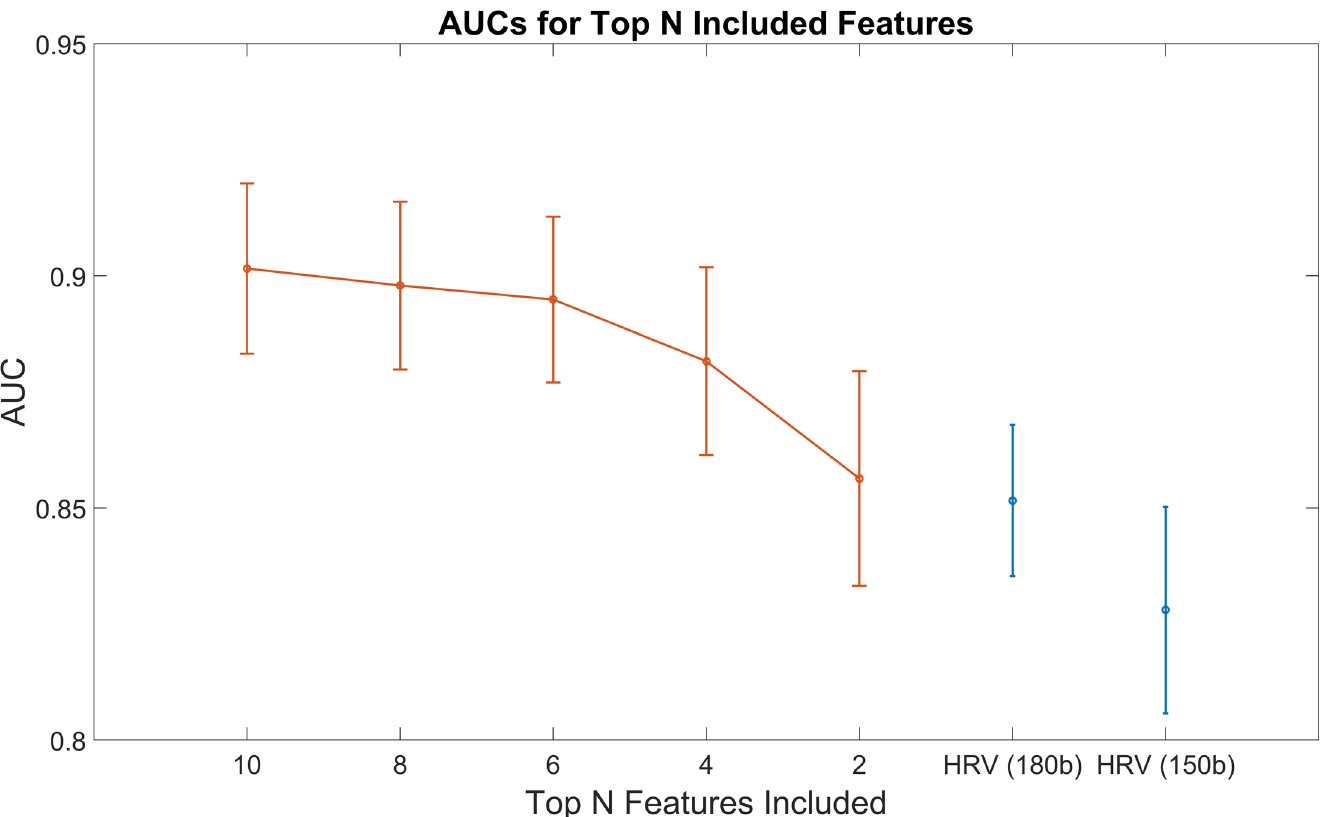
Fig 8. Featureset Sizes. Area under the curve calculated choosing the top ten, eight, six, four, and two features from the presented features ’ best-performing window size (120-beats). The AUC for the Typical HRV features ’ best performing window size (150-beats) is included (in blue) for comparison. The presented features continue to outperform the entire typical HRV feature set even when reduced to just four of the original ten features. The error bars indicate 95% confidence intervals.